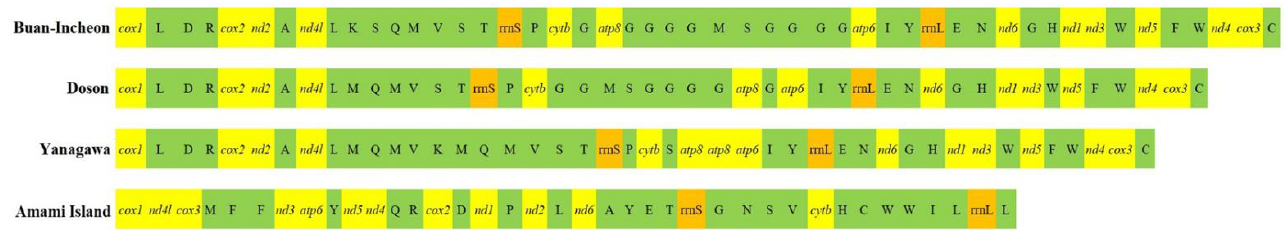
Figure 1. Gene organizations of Lingula anatina mitogenomes from Buan-Incheon (Korea), Doson (Vietnam), Yanagawa and Amami Island (Japan). Color indicators represent different groups: Yellow: Protein-coding genes, Green: tRNA genes, Orange: rRNA genes.